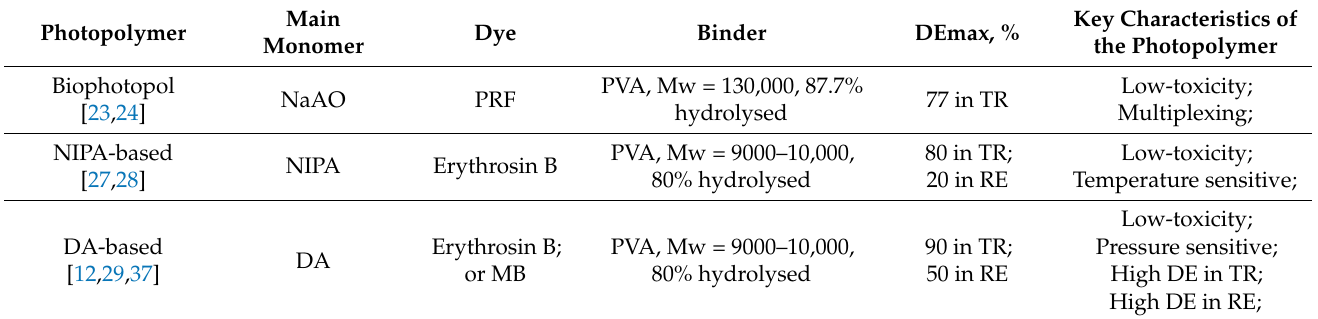
Table 1. Review summary of the basic chemical composition of the low-toxicity photopolymers and their key